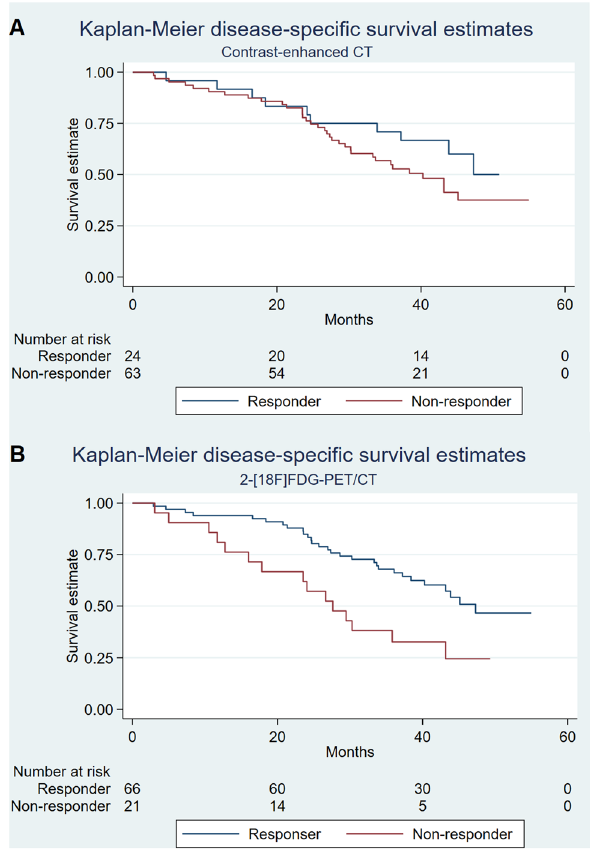
Figure 2. Kaplan–Meier plot of disease-specific survival for responders and non-responders on ( A ) CE-CT and ( B ) 2-[ 18 F]FDG-PET/CT on the first follow-up scans.